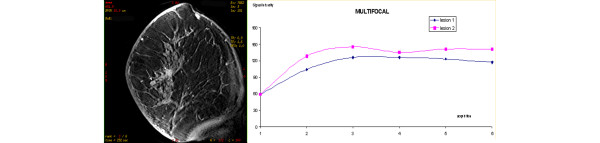
Magnetic resonance mammography 2 years after therapies for invasive ductal carcinoma. This shows two lesions (arrows) (Breast Imaging Reporting and Data System IV, V), reported by biopsy as malignant.